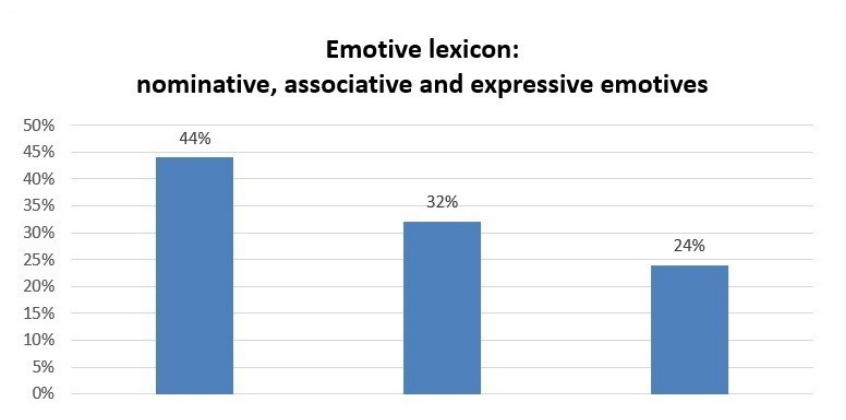
Figure 1 - Emotive lexicon in sports reports DOI: https://doi.org/10.18454/RULB.2023.40.40.7